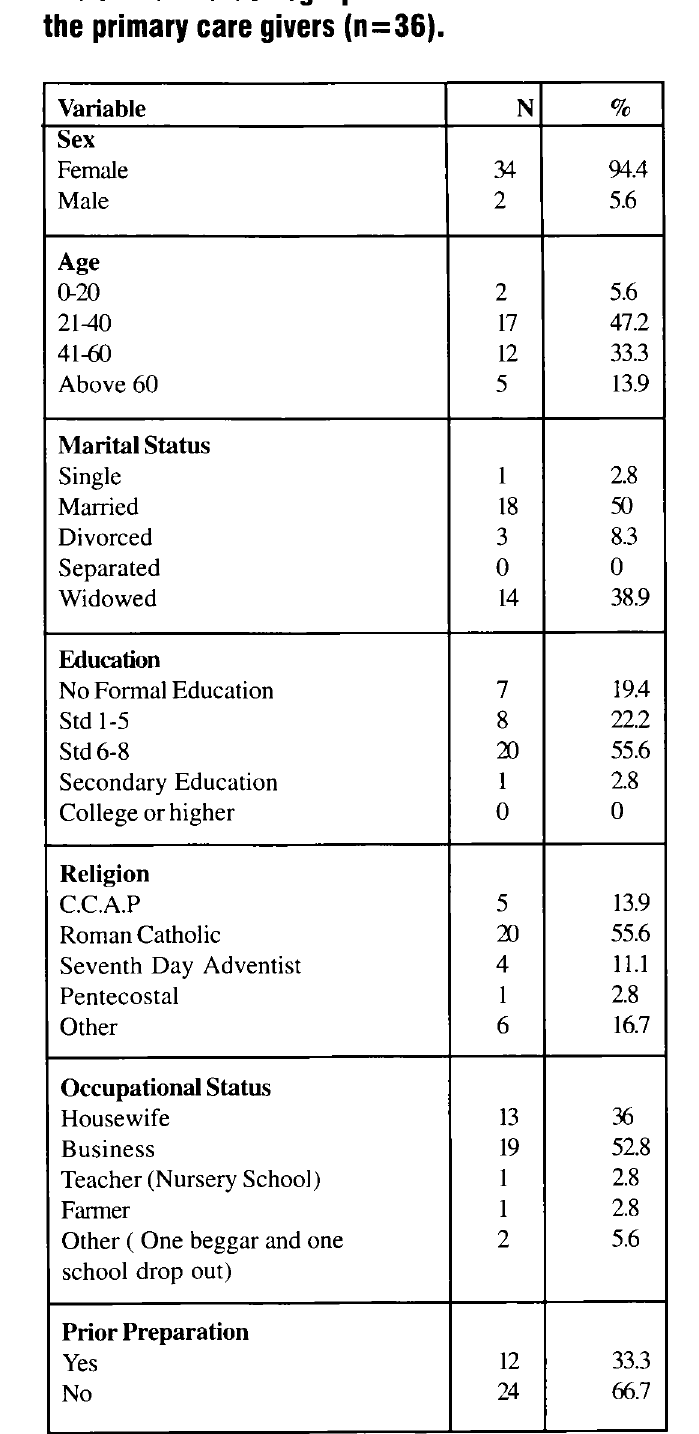
Table 1 : Socio-demographic characteristics of the primary care givers (n = 36